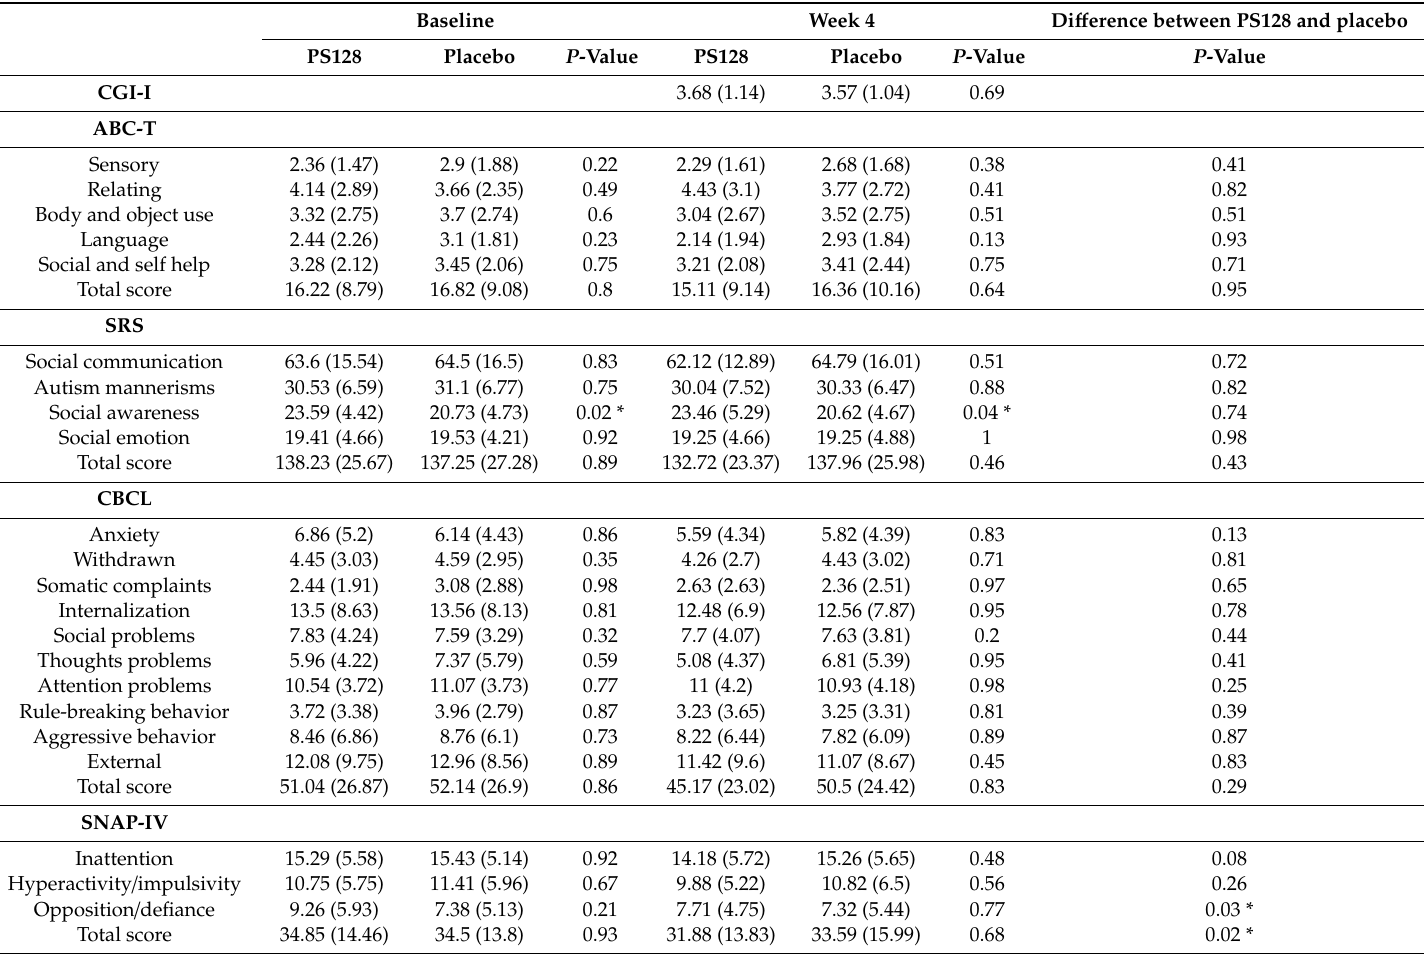
Table 4. Age stratified analysis of outcomes for subjects aged 7–12 years